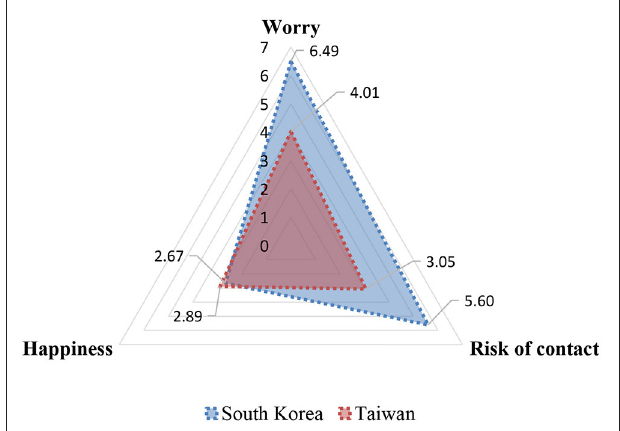
FIGURE 1 | Comparison of mean scores for three aspects of mental health